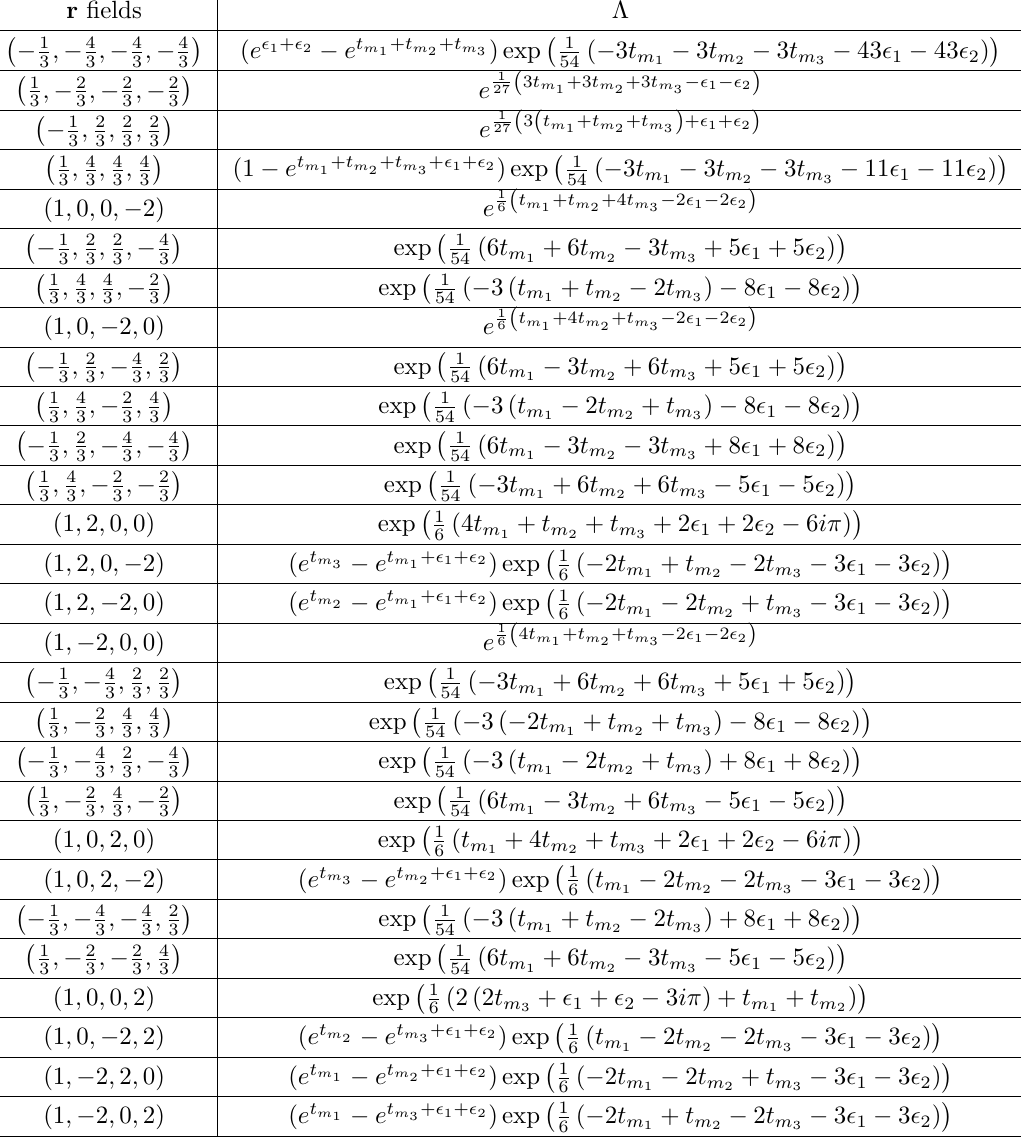
Table 3 . The non-equivalent unity r (cid:12)elds and (cid:3) of local B